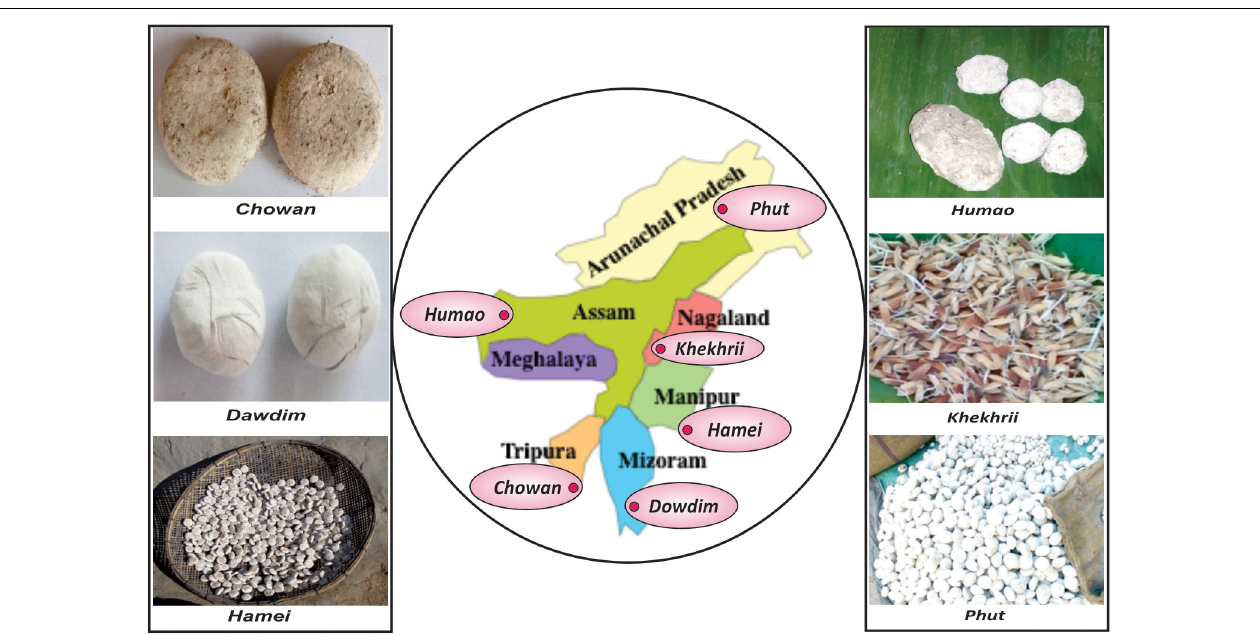
FIGURE 1 | Origin and types of sun-dried alcoholic starter cultures in eight North East states of